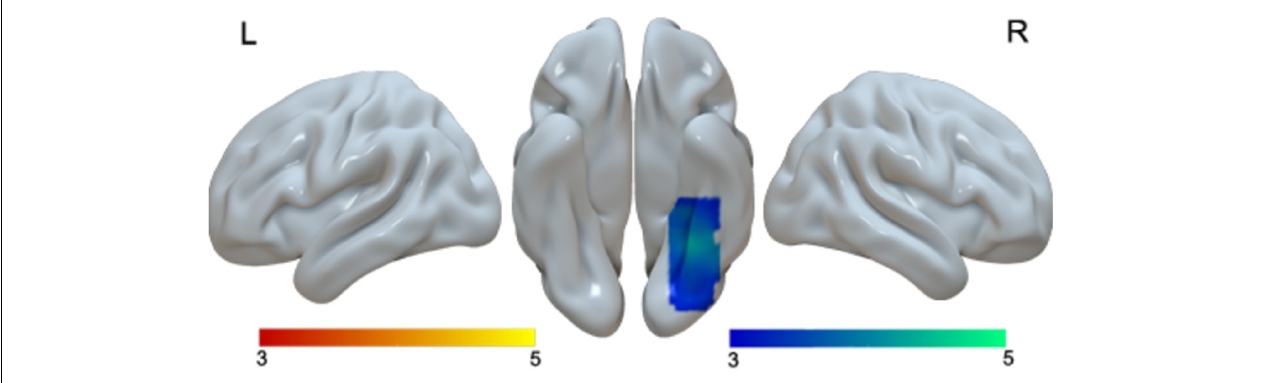
FIGURE 3 | Brain activation in the main effect of age. Brain regions that were more activated in children than in adults (blue). No brain regions were more activated in adults than in